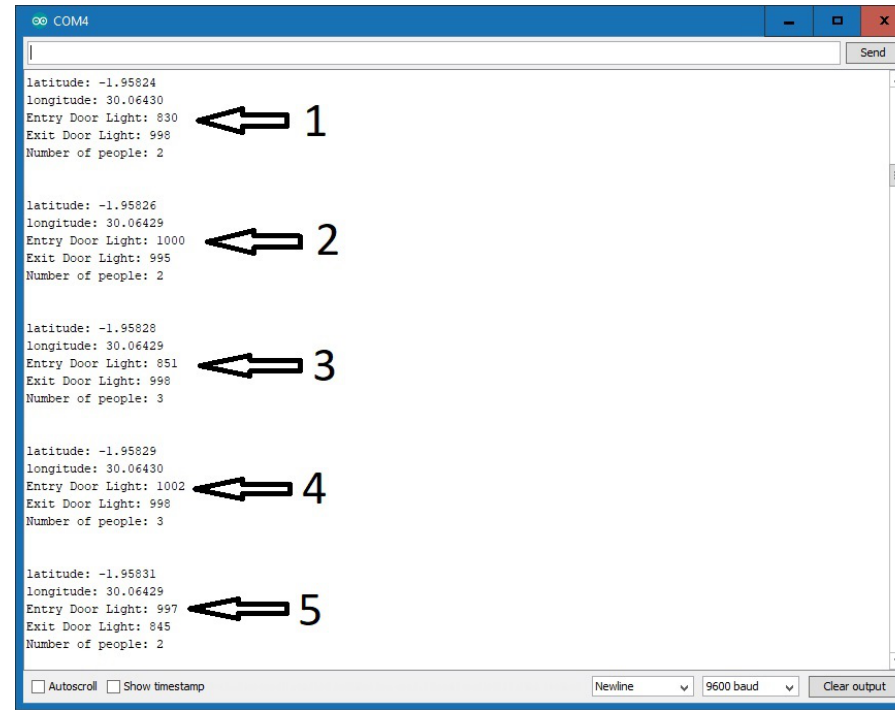
Figure 9. Arduino Uno serial monitor displaying captured